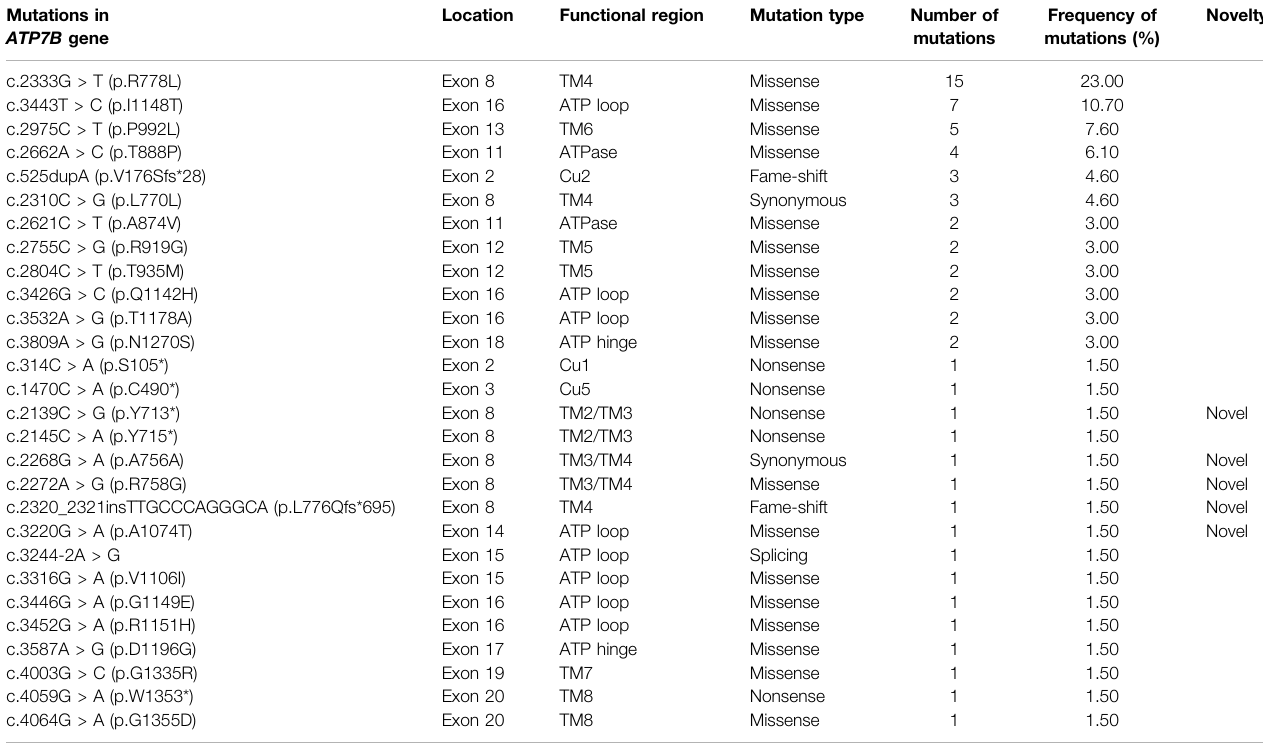
TABLE 2 | Information of ATP7B gene mutations in 30 children with WD.